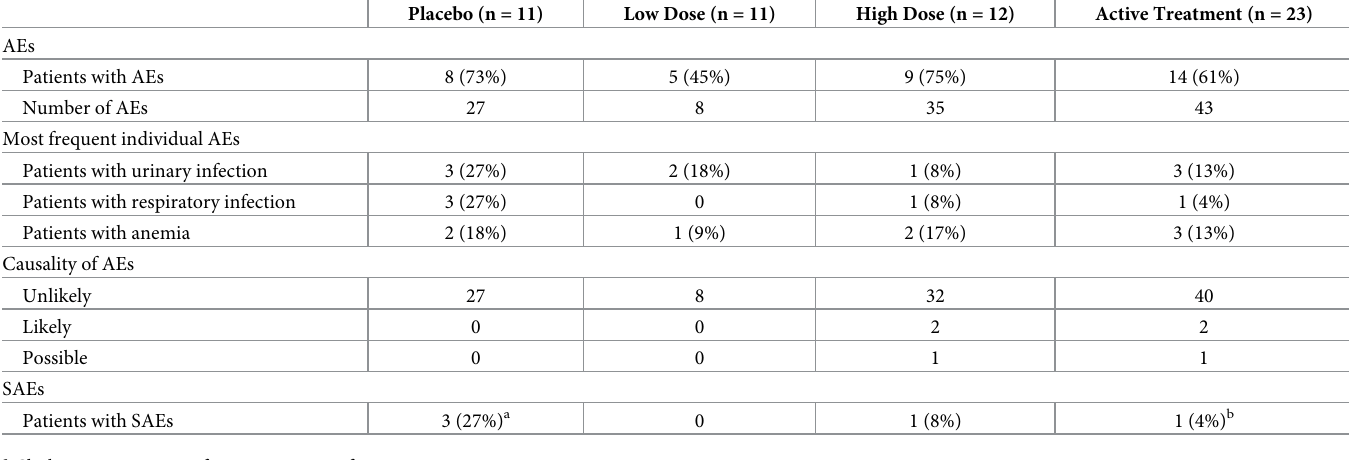
Table 2. Adverse events during the